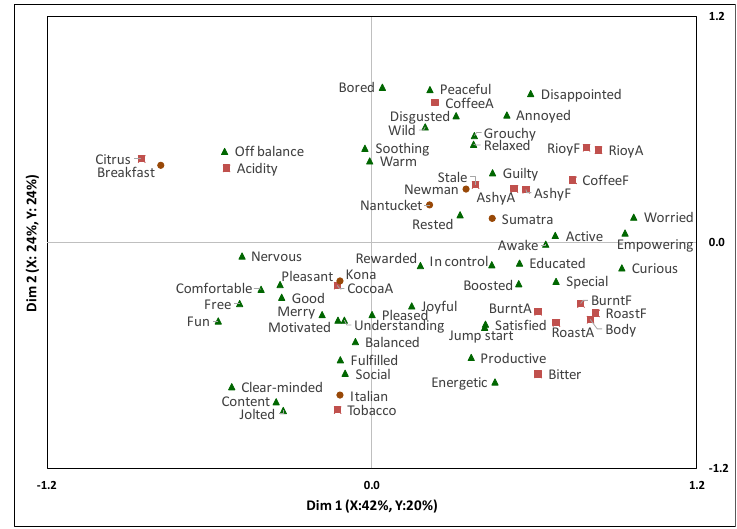
Figure 2. Partial least square regression analysis of descriptive sensory and CDE emotion lexicon of the six coffee samples for 94 consumers.